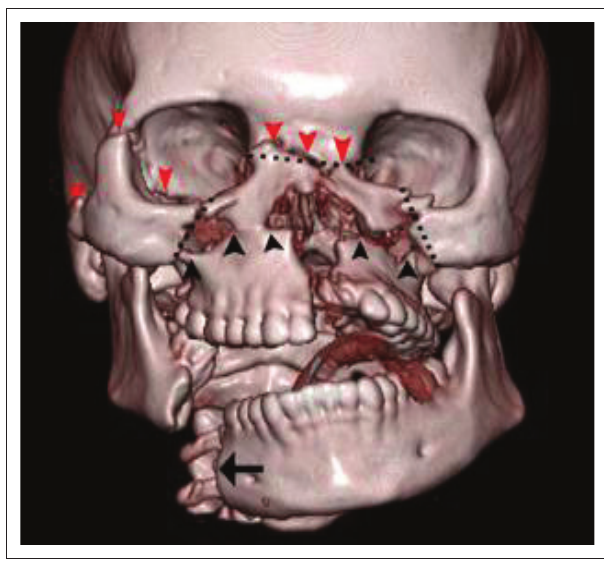
FIGURE 3: 3D reconstructed CT scan of the facial bones of a 40-year-old woman involved in a MVC as a passenger, showing bilateral markedly displaced Le Fort I (black arrowheads), Le Fort II (dotted line) and right Le Fort III (red arrowheads) fractures. Additionally, there is a fracture of the body of the right mandible (black arrow) and dislocation of the left temporomandibular joint (not